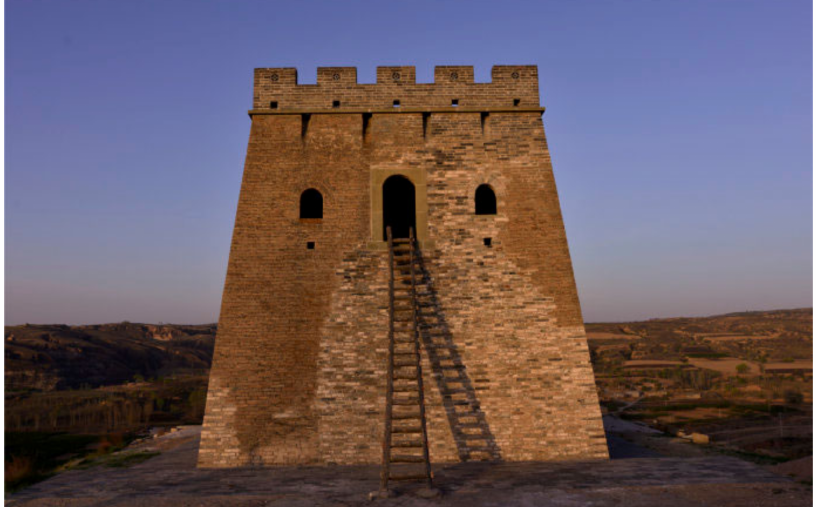
Figure 2. Dondae Forts of China, with a fortress oat each corner of Fugu County, Yulin City, Shaanxi